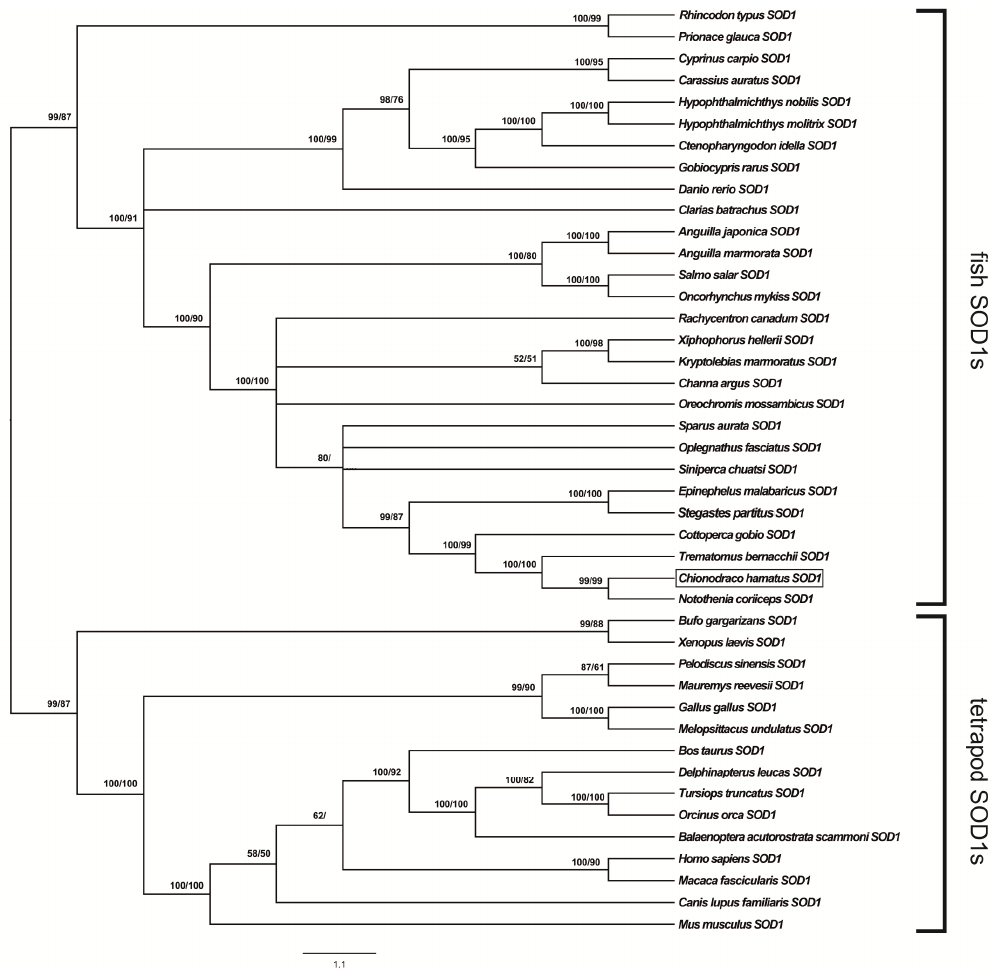
Figure 1. Phylogenetic relationships among SOD1s of various organisms reconstructed on the basis of the cDNA coding region sequences and using both Bayesian interference (BI) and maximum likelihood (ML) methods. Bayesian posterior probability (first number) and bootstrap values higher than 50% are indicated on each node, respectively. The scale for branch length (1.1 substitution/site) is shown below the tree. C. hamatus SOD1 is boxed.